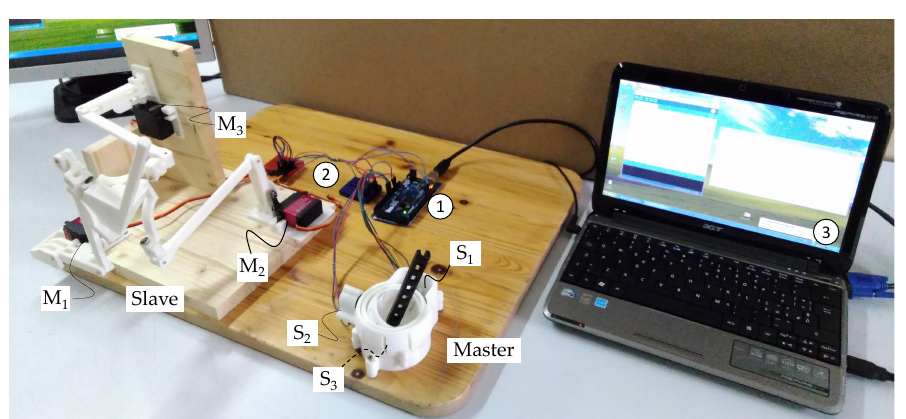
Figure 16. System control scheme.